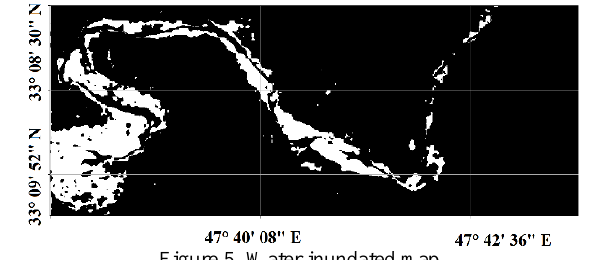
Figure 5. Water inundated map